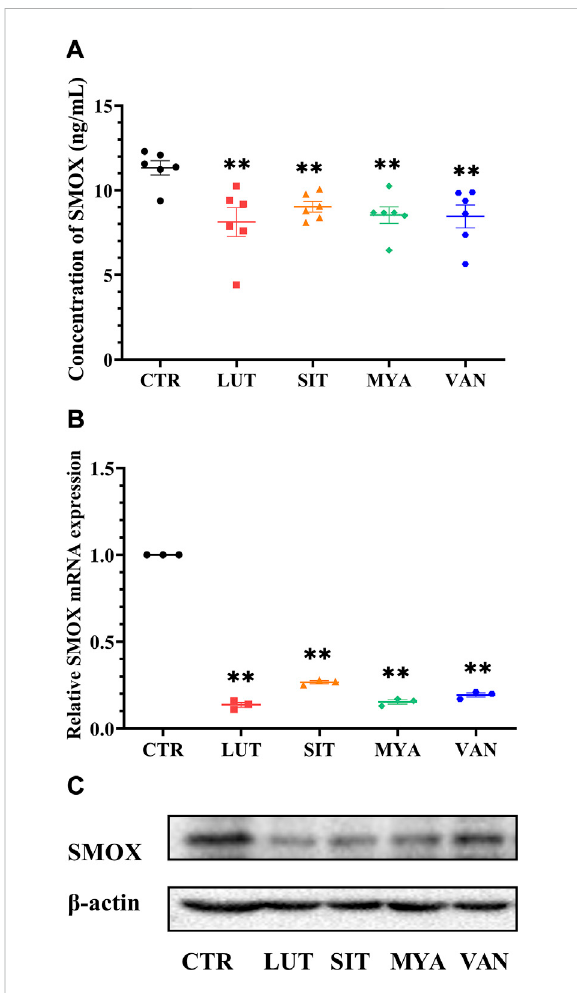
FIGURE 11 Effect of YFBP active ingredients on SMOX production and the expression of SMOX. (A) Level of SMOX was measured using ELISA kits. (B) mRNA expression of SMOX in the tumor tissue was measuredbyqRT-PCR. (C) ProteinexpressionofSMOXinthe tumor tissue was measured by Western blotting. Quantitative results are shown as the mean ± SEM from three independent experiments. ** p < 0.01 vs. the CTR